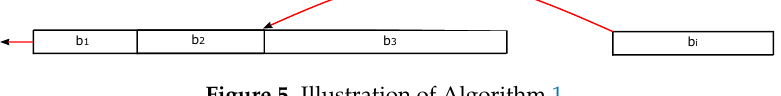
Figure 5. Illustration of Algorithm 1.